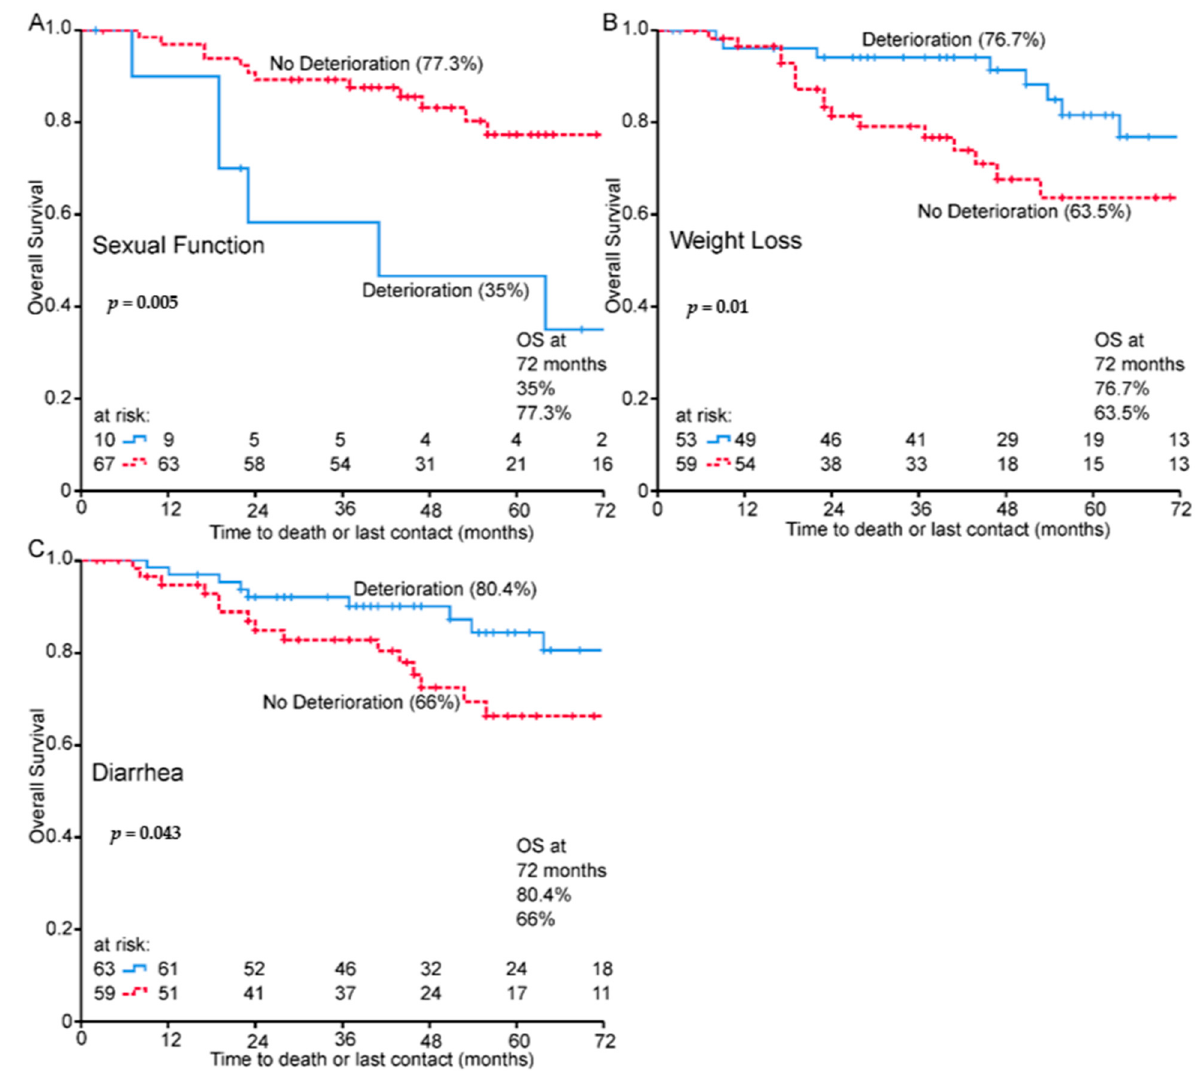
Figure 5. Change scores treatment Kaplan–Meier charts for overall survival and ( A ) sexual function, ( B ) weight loss and ( C ) diarrhea, 72-month OS% in